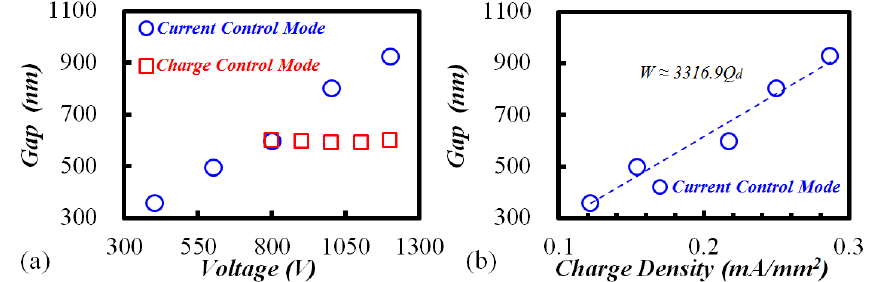
Figure 2. With temperature 350 °C and 10 min etching: ( a ) gap width vs. bonding voltage; ( b ) gap width vs. charge density.